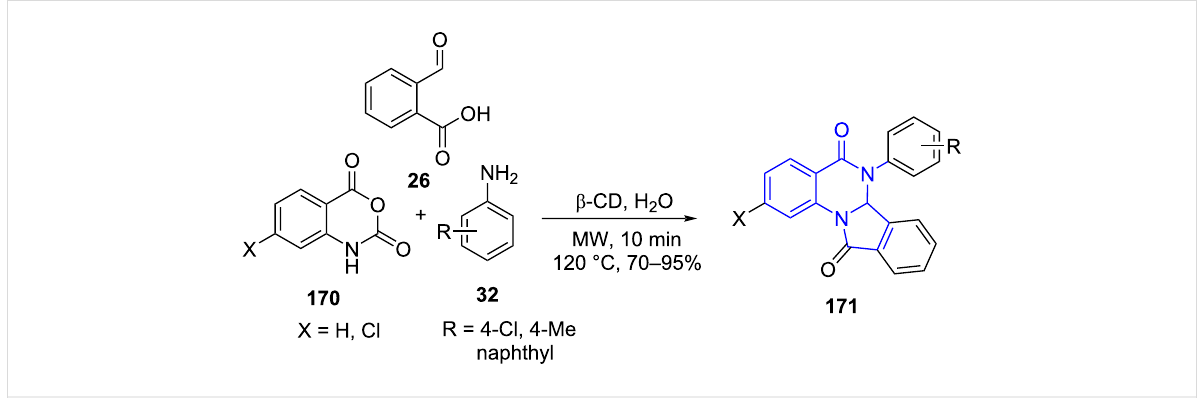
Scheme 71: β -Cyclodextrin-mediated synthesis of indoloquinazolinediones.